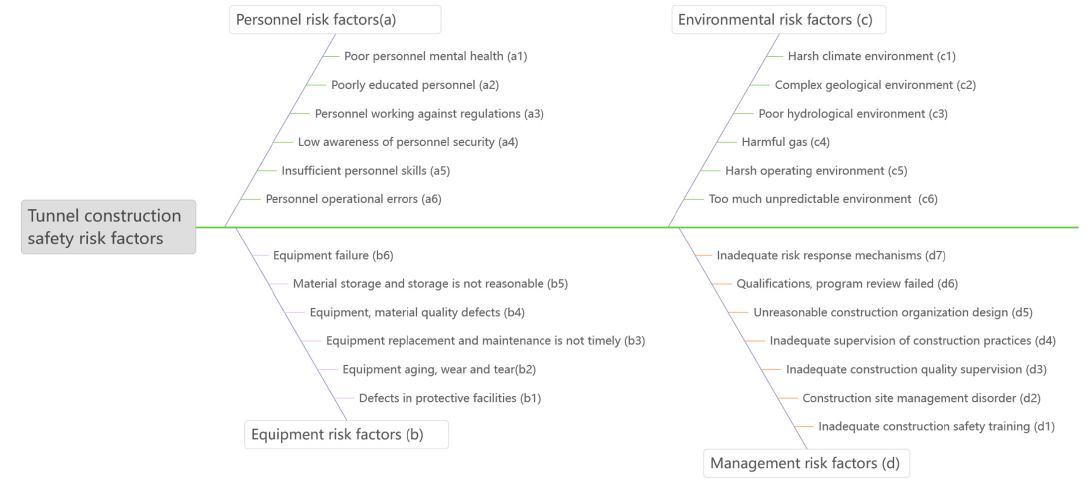
Figure 2. Results of risk factor identi fi cation based on the grounded